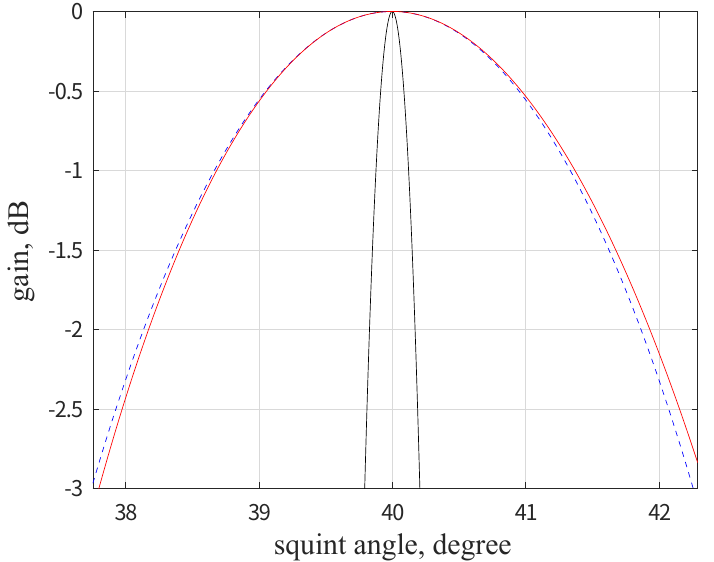
Figure 3. Comparison of AAPs. The solid red is the squint beam-steering pattern, the solid black is the physical beam pattern, and the dashed blue is the k φ -scaled physical beam